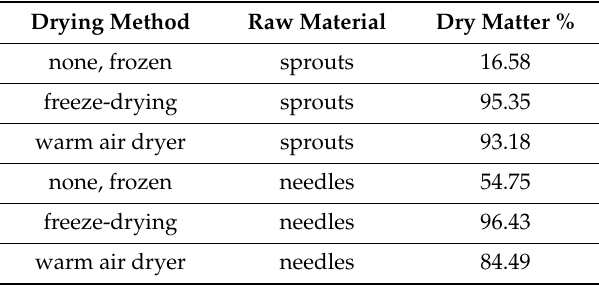
Table 1. Dry matter content of Norway spruce sprouts and older needles as fresh and after di ff erent drying